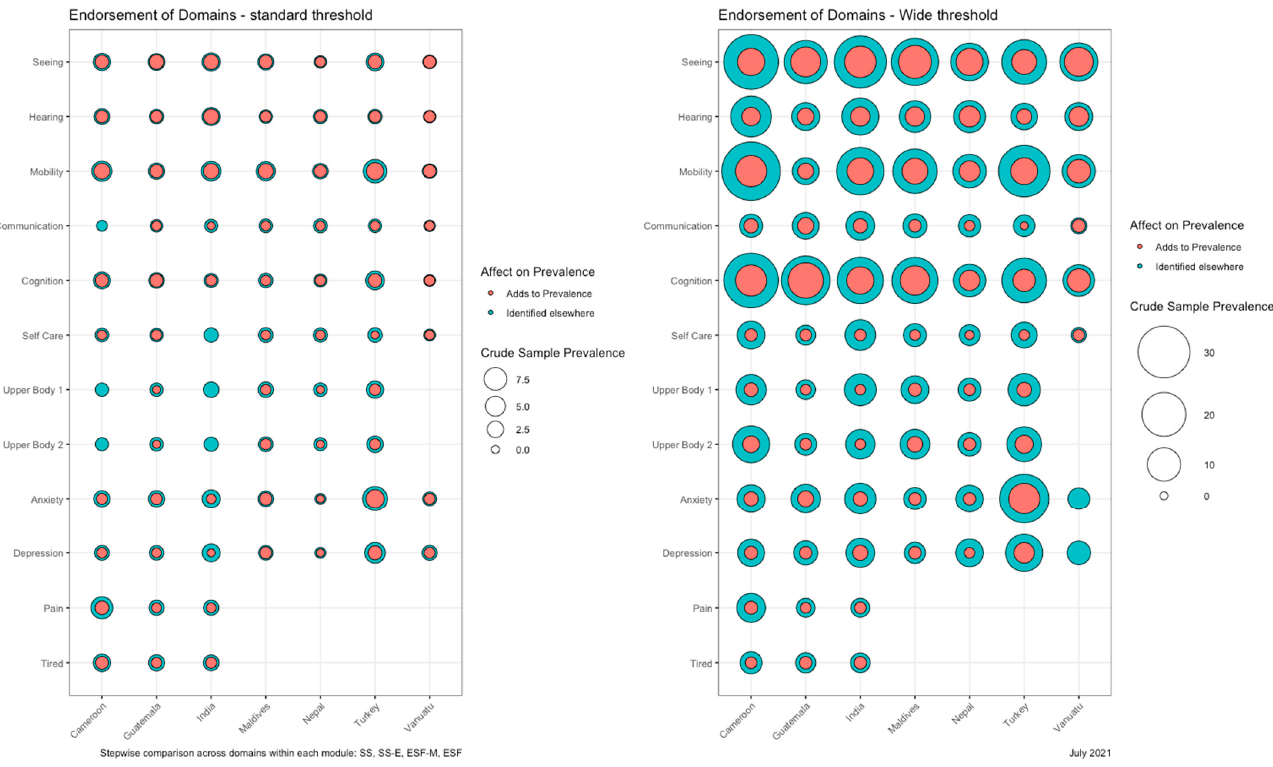
Figure 1. Reported difficulties in domains using standard and wide thresholds.